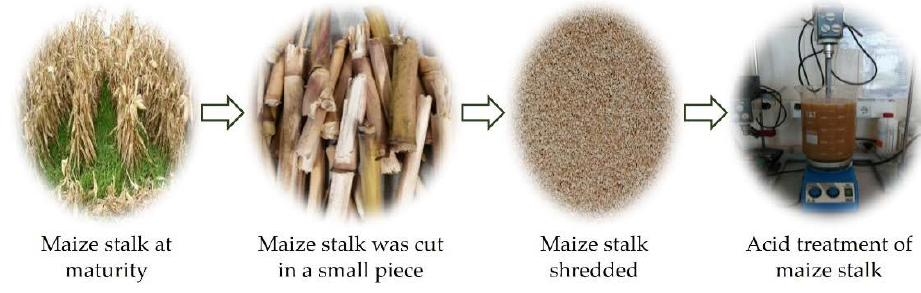
Figure 1. Schematic images for obtained shredded maize stalk applied for acid treatment.